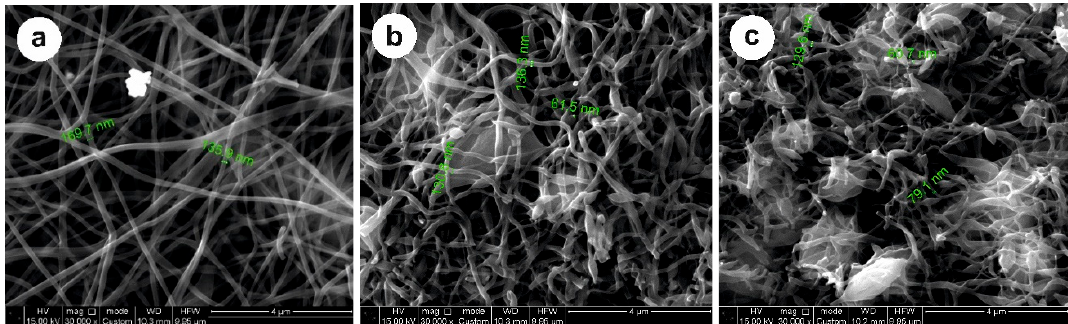
Figure 1. SEM images of carbon fibers at: ( a ) 800 °C; ( b ) 900 °C; ( c ) 1000 °C. The fiber diameters vary from 60 nm to 170 μ m (SEM images in Figure 1), and do not change substantially at different carbonization temperatures. An exception is LCF800 °C, where more aligned fibers are observed (Figure 1a). This could be caused by different degrees of carbonization because of a lower temperature compared with fibers carbonized at 900 and 1000 °C (see Figure 1b,c). Depending on the constituents in the shell, this could influence the electrochemical performance. The XRD and Raman spectra of carbon fibers are shown in Figure 2 and Figure 3, respectively.